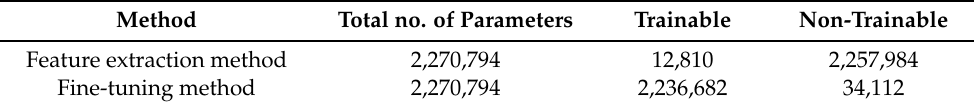
Table 3. Comparison of transfer learning methods on MobileNetV2 model utilized in this work Section 2.3.1 in terms of